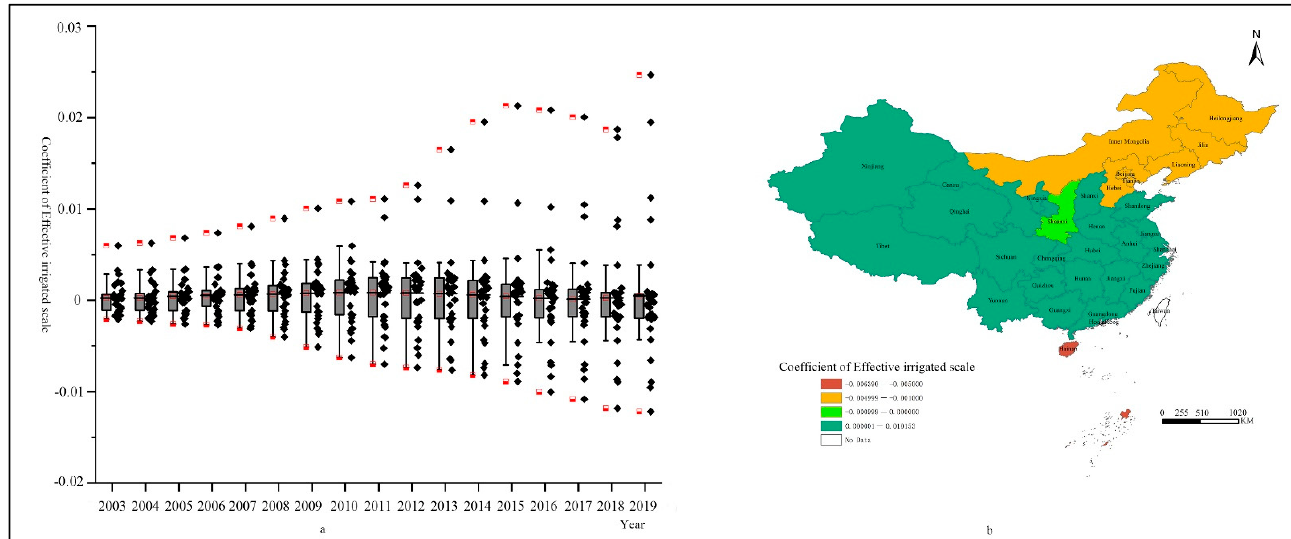
Figure 11. ( a ) Box-plot of regression coefficients of the effective irrigated scale; ( b ) Distribution of mean value of regression coefficients of the effective irrigated scale.